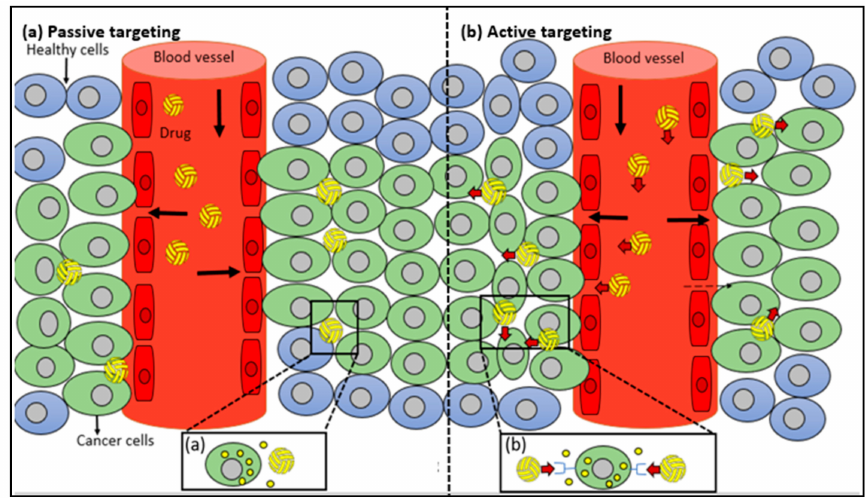
Figure 10. Schematic illustration of ( a ) Passive targeting; ( b ) Active